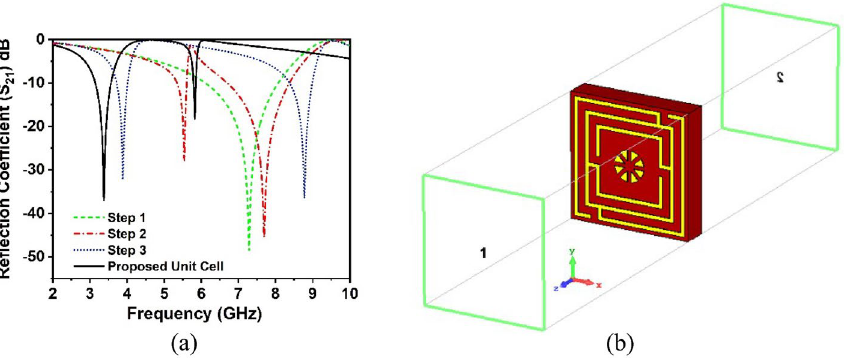
Figure 2. ( a ) Reflection coefficient spectra for different design phases. ( b ) CST Simulation arrangement (CST STUDIO SUITE 2019, https:// www. 3ds. com/ produ cts- servi ces/ simul ia/ produ cts/ cst- studio- suite) 39 .